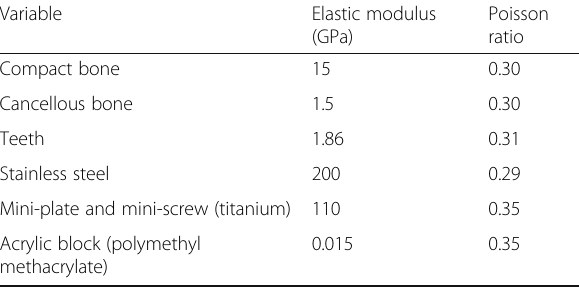
Table 1 Mechanical properties of the materials in the